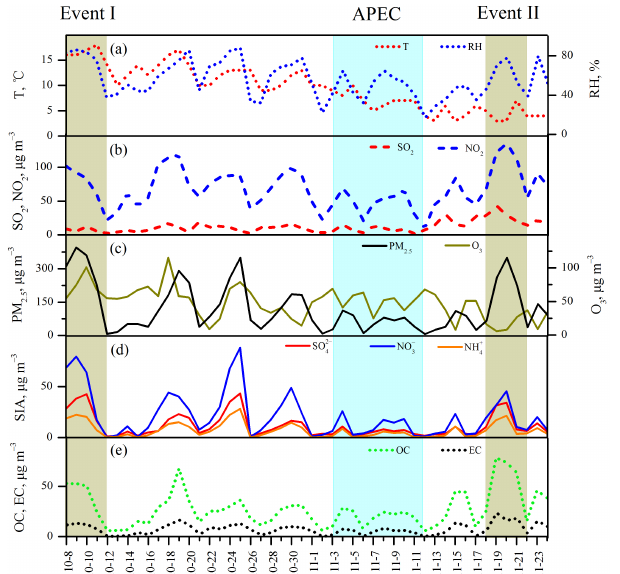
Figure 1. Temporal variations of meteorological conditions, gaseous pollutants and major components of PM 2 . 5 during the 2014 APEC campaign. (The green shadows represent two air pol- lution events characterized by highest PM 2 . 5 levels before and after APEC, while the blue shadow represents the APEC event).